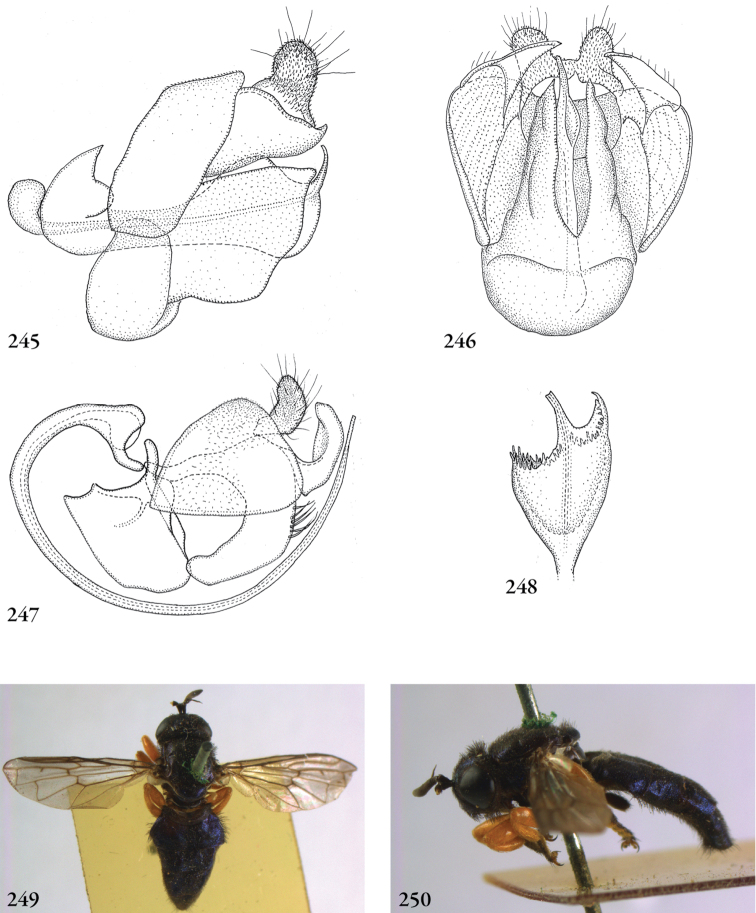
245–246
Mixogaster breviventris male (USA, coll. RMNH), genitalia: 245 lateral 246 ventral. Figure 247.
Mixogaster thecla male (Brazil, coll. J.T. Smit), genitalia lateral 248
Mixogaster spec. nov. male (Colombia, coll. RMNH), aedeagus ventral 249–250
Oligeriops dimorphon female (Australia, coll. BMNH): 249 habitus dorsal 250 habitus lateral.